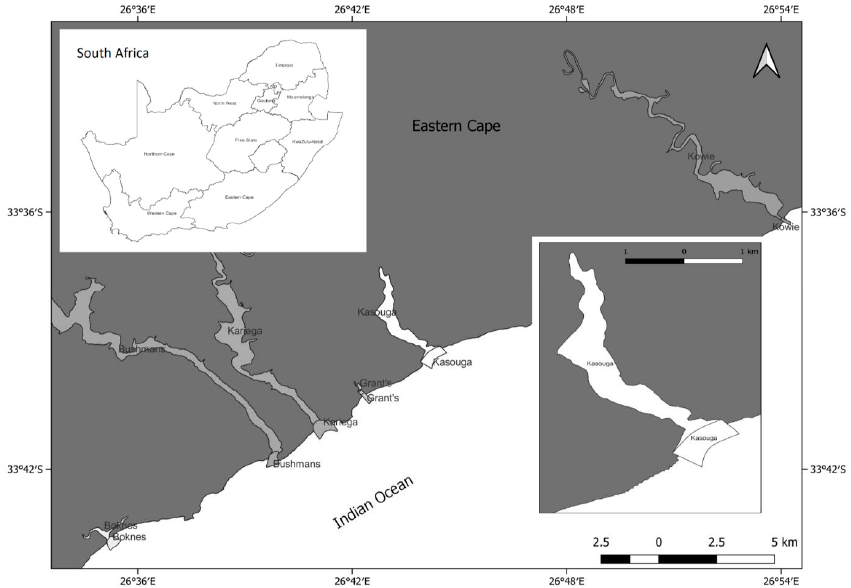
Figure 1. Geographic location of the temporarily open/closed Kasouga Estuary located along the southeastern coastline of South Africa.